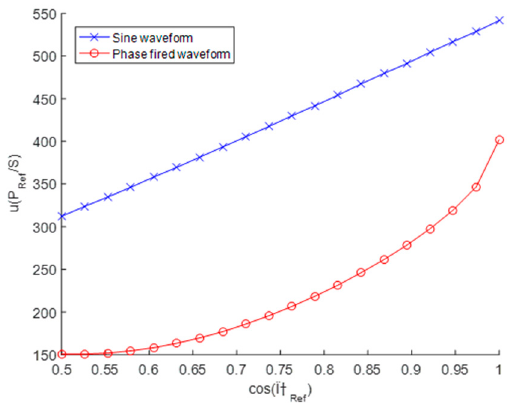
Figure 10. Active power uncertainties relative to the apparent power computed with Monte Carlo method.